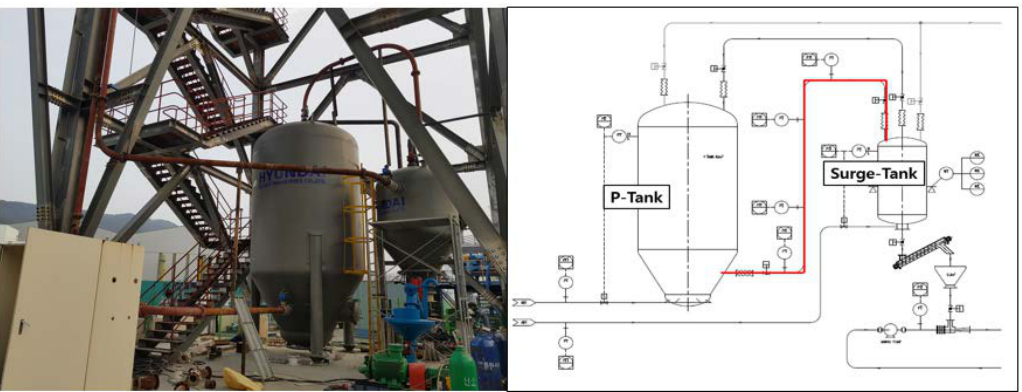
Table 4. Comparison of empirical data and simulation results